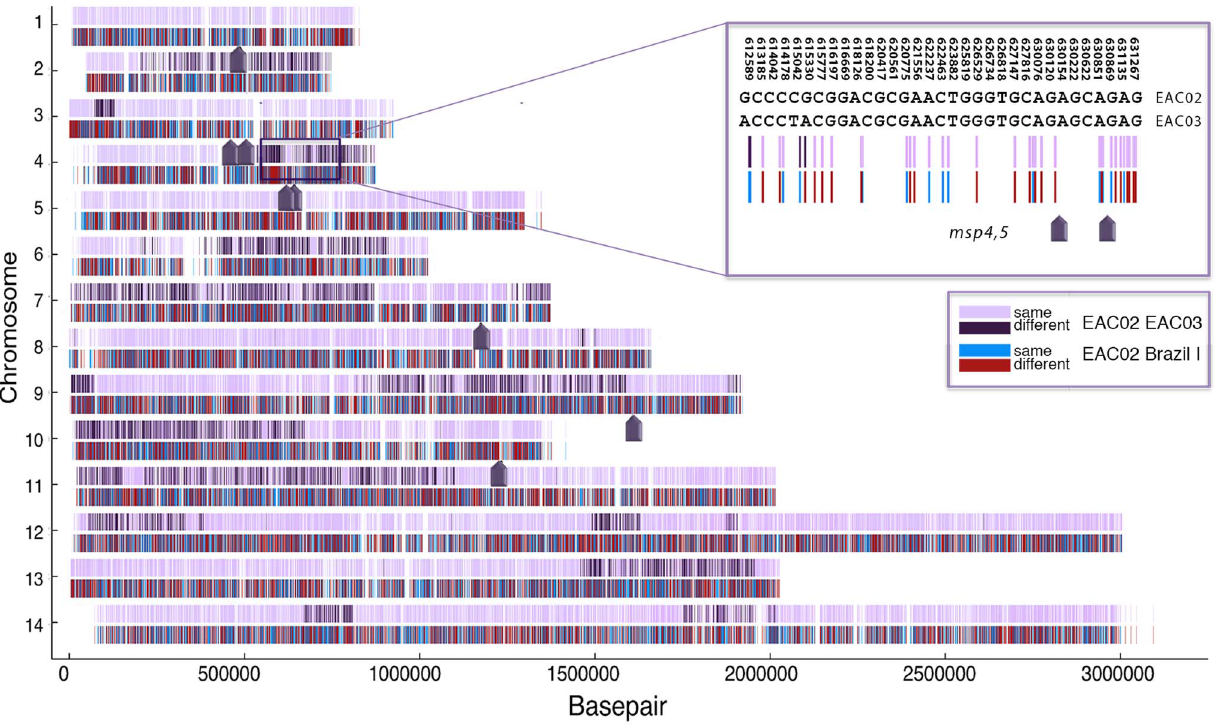
Figure 3. Pairwise comparison of EAC02 and EAC03. A set of 23,755 SNVs confidently genotyped (20 or more reads) in EAC02, EAC03 and Brazil I and which are different from SalI are presented across 14 chromosomes. SNVs shared between the two strains are shown in lavender and positions where the two strains differ are shown in dark purple, revealing large regions of identity. The positions of the eight-microsatellite markers (Table 3) are indicated by arrows, including the region on chromosome 4 where the msp4 and msp5 markers are in a region of homozygosity surrounded by regions of heterozygosity (inset). Despite the two samples being identical at the eight microsatellite markers, they differ at many positions in the genome. A comparison between EAC02 and a Brazil I control strain (in red and blue) shows that the two strains are highly diverged and do not share blocks of contiguous DNA sequence.